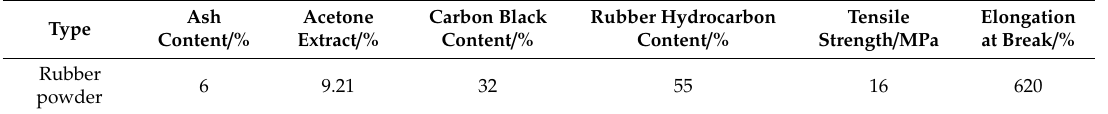
Table 2. Properties of rubber